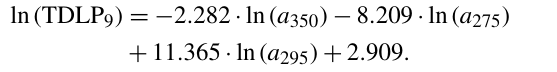
Fig. 2a. During summertime, the coastal currents